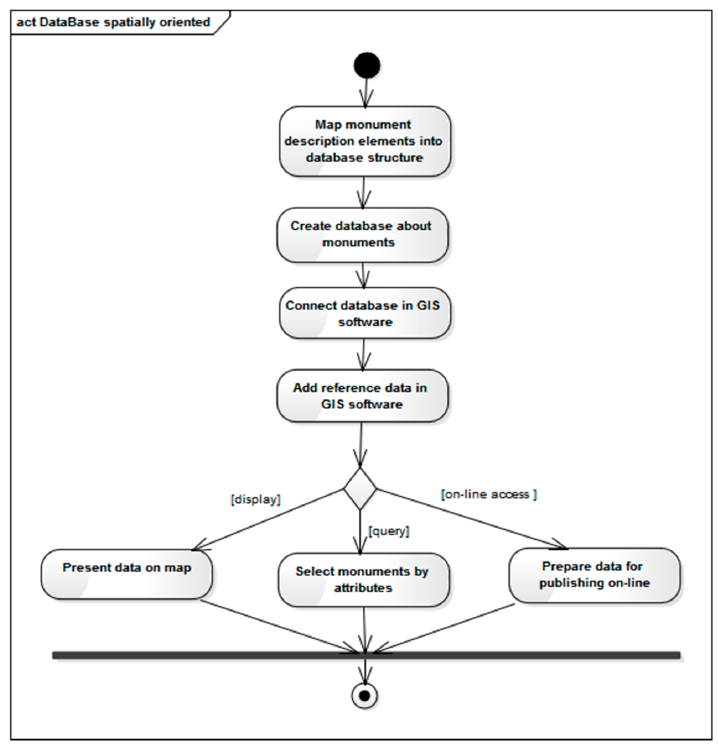
Figure 6. Development of spatial database about monuments (source: own work).